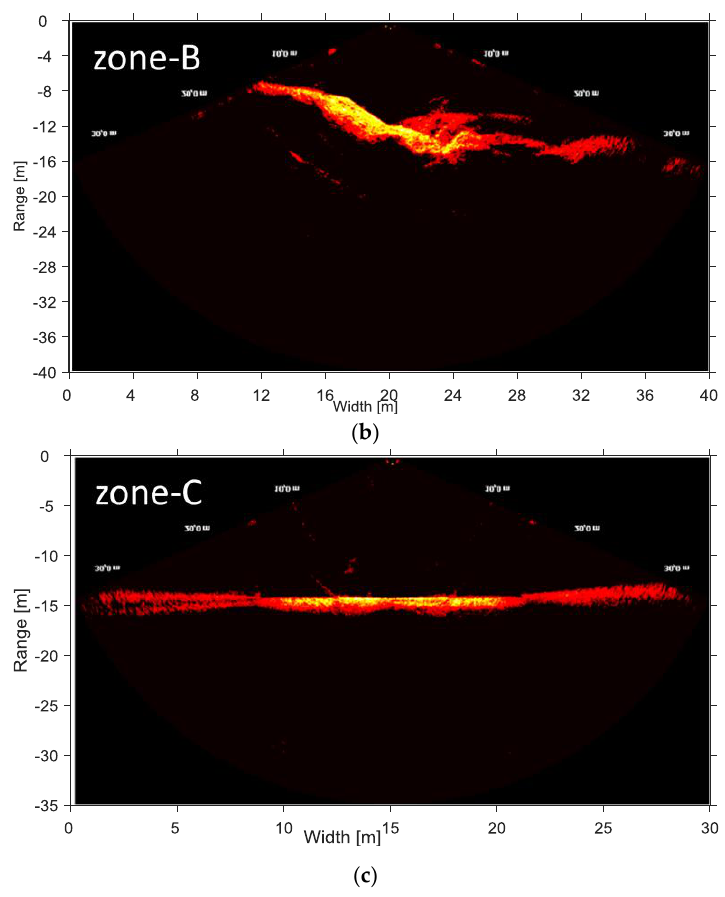
Figure 6. Acoustic images acquired using the MBS system in the surveyed path. ( a ) Zone-A has a rather flat seabed configuration containing disperse stones; ( b ) Zone-B has a rocky seabed and is rather shallow and narrow; ( c ) Zone-C is also mostly flat and deeper than zone-A.